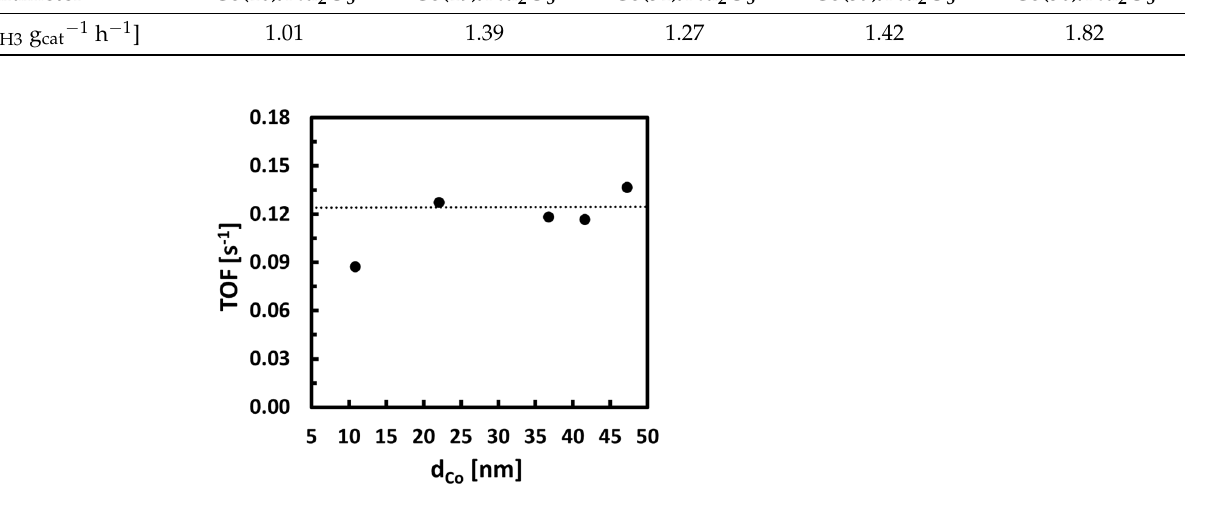
Table 4. The activity of Co/Nd 2 O 3 catalysts in ammonia synthesis reaction expressed as the average reaction rate (r avg ) and TOF.